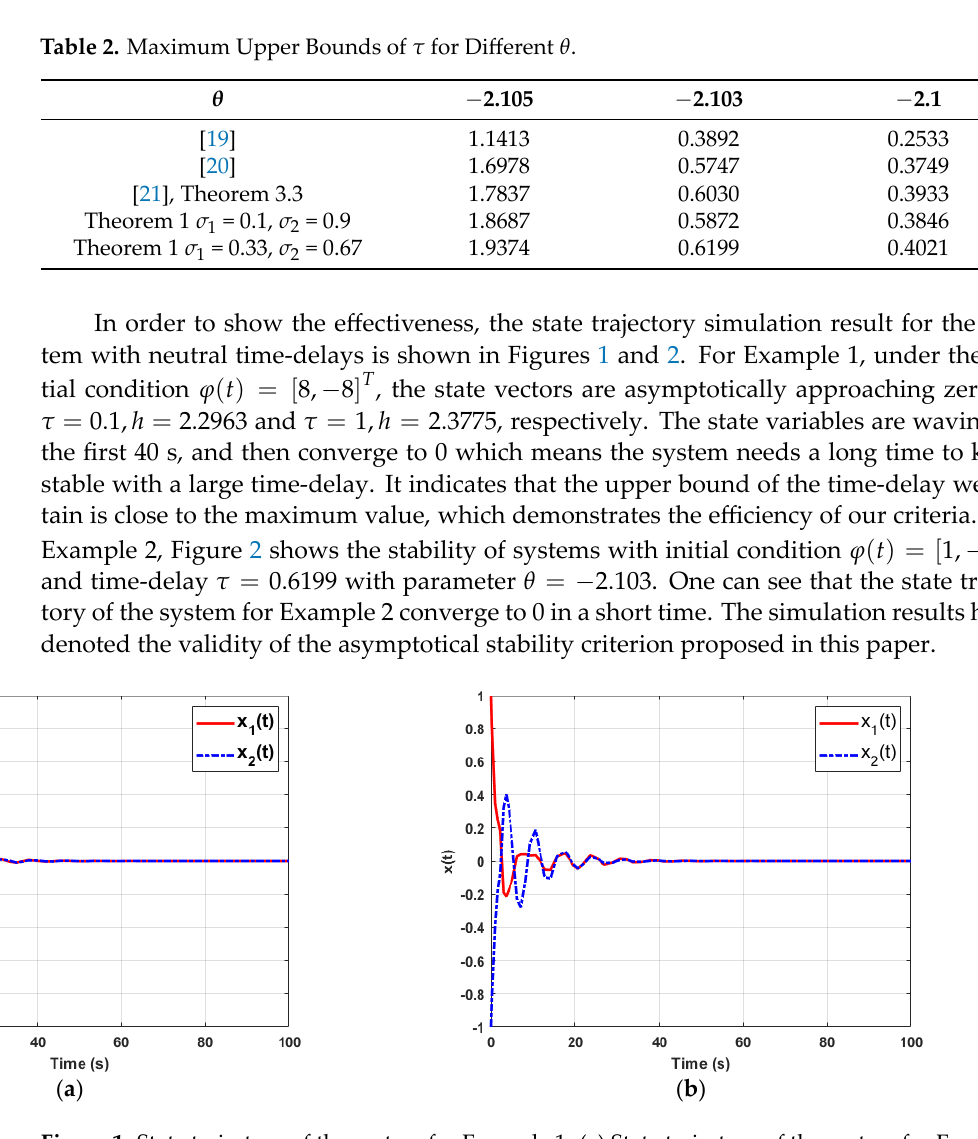
θ τ for Different .